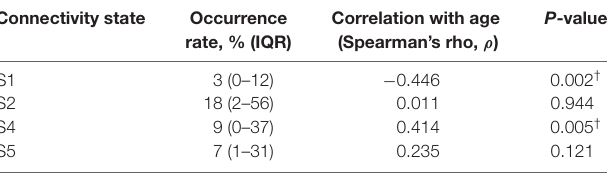
TABLE 2 | Connectivity state occurrence rates and correlations with age. Connectivity state